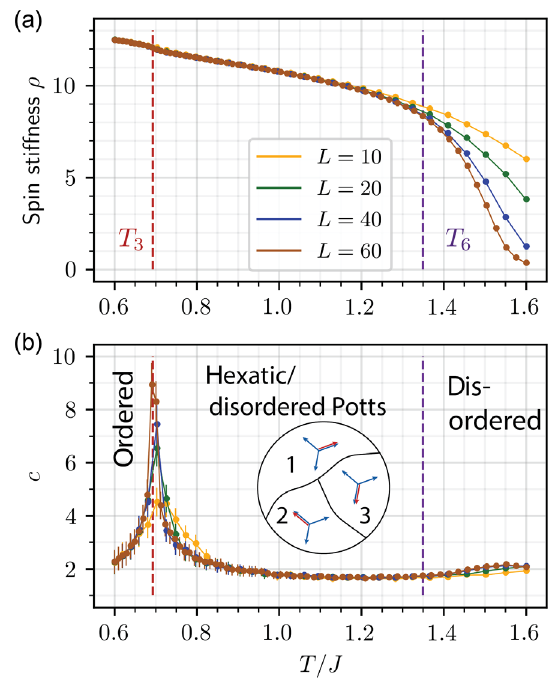
FIG. 5. Thermodynamic observables at Δ ¼ 0 . 5 for systems with linear sizes up to L ¼ 60 , replicating the results of Ref. [34] which is used as a benchmark. (a) Total spin stiffness ρ defined in Eq. (4.7) as a function of the temperature T=J . Upturn at T 6 signals KT transition into the hexatic phase. The transition temperature is determined most accurately using the universal jump criterion ρ ð T − 18 T = π , which yields T Δ ¼ 0 . 5 Þ ¼ 1 . 35 (cid:3) 0 . 01 . 6 6 ð 6 Þ ¼ (b) Specific heat per site c as a function of the temperature T=J . While c exhibitsa broad maximumabove thehexatic-KT transition at 1 . 1 T 6 ,itdevelopsasharppeakatthelowertransitionat T 3 ,which increases with system size L . This is characteristic of the Potts phase transition in 2D, where c ∼ t − α with exponent α ¼ 1 = 3 . We extract the transition temperature T 3 ð Δ ¼ 0 . 5 Þ ¼ 0 . 693 (cid:3) 0 . 005 fromthelocationofthemaximumof c for L ¼ 60 .Theinsetdepicts the three Z 3 domains with different relative hexatic-nematic ordering in the hexatic phase. Long-range Z 3 order develops only at the lower T 3